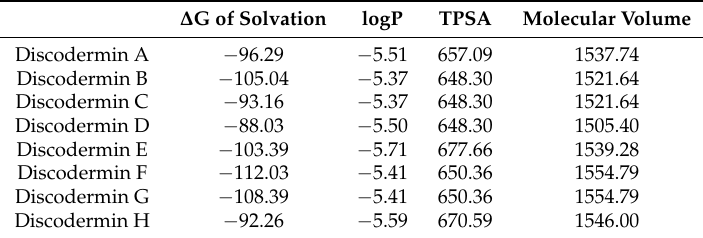
Table 1. Predicted parameters useful for QSAR studies for the Discodermins A–H family of